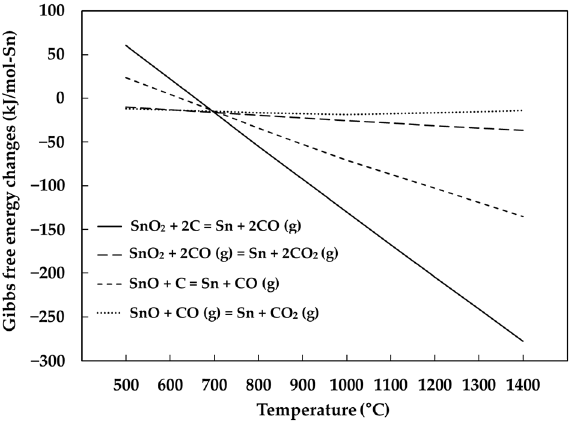
Figure 7. The Gibbs free energy changes for carbothermic reduction of SnO 2 .